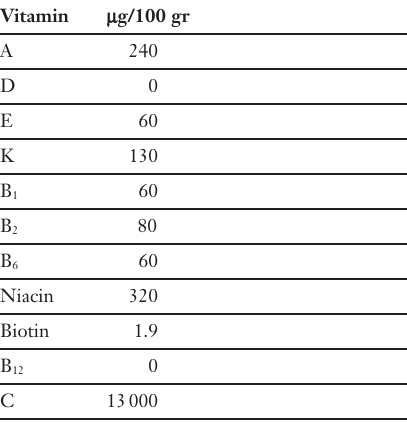
Vitamin content of Eruca Sativa L.